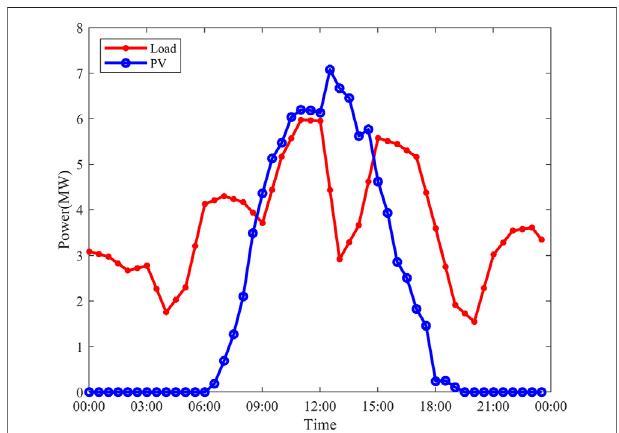
FIGURE 4 | PV and load prediction curves in a typical PV industrial park microgrid.